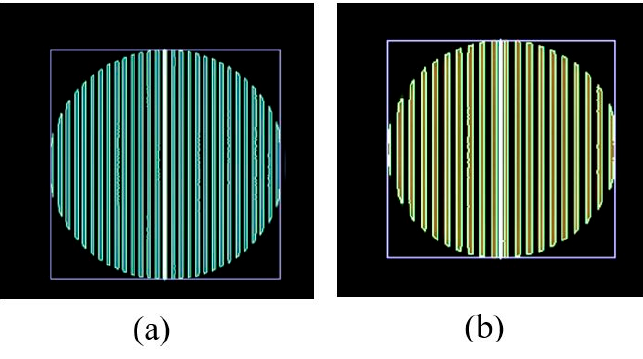
Figure 27. ROI contour feature. ( a ) Captured image of 4 kHz signal. ( b ) Captured image of 2 kHz signal.